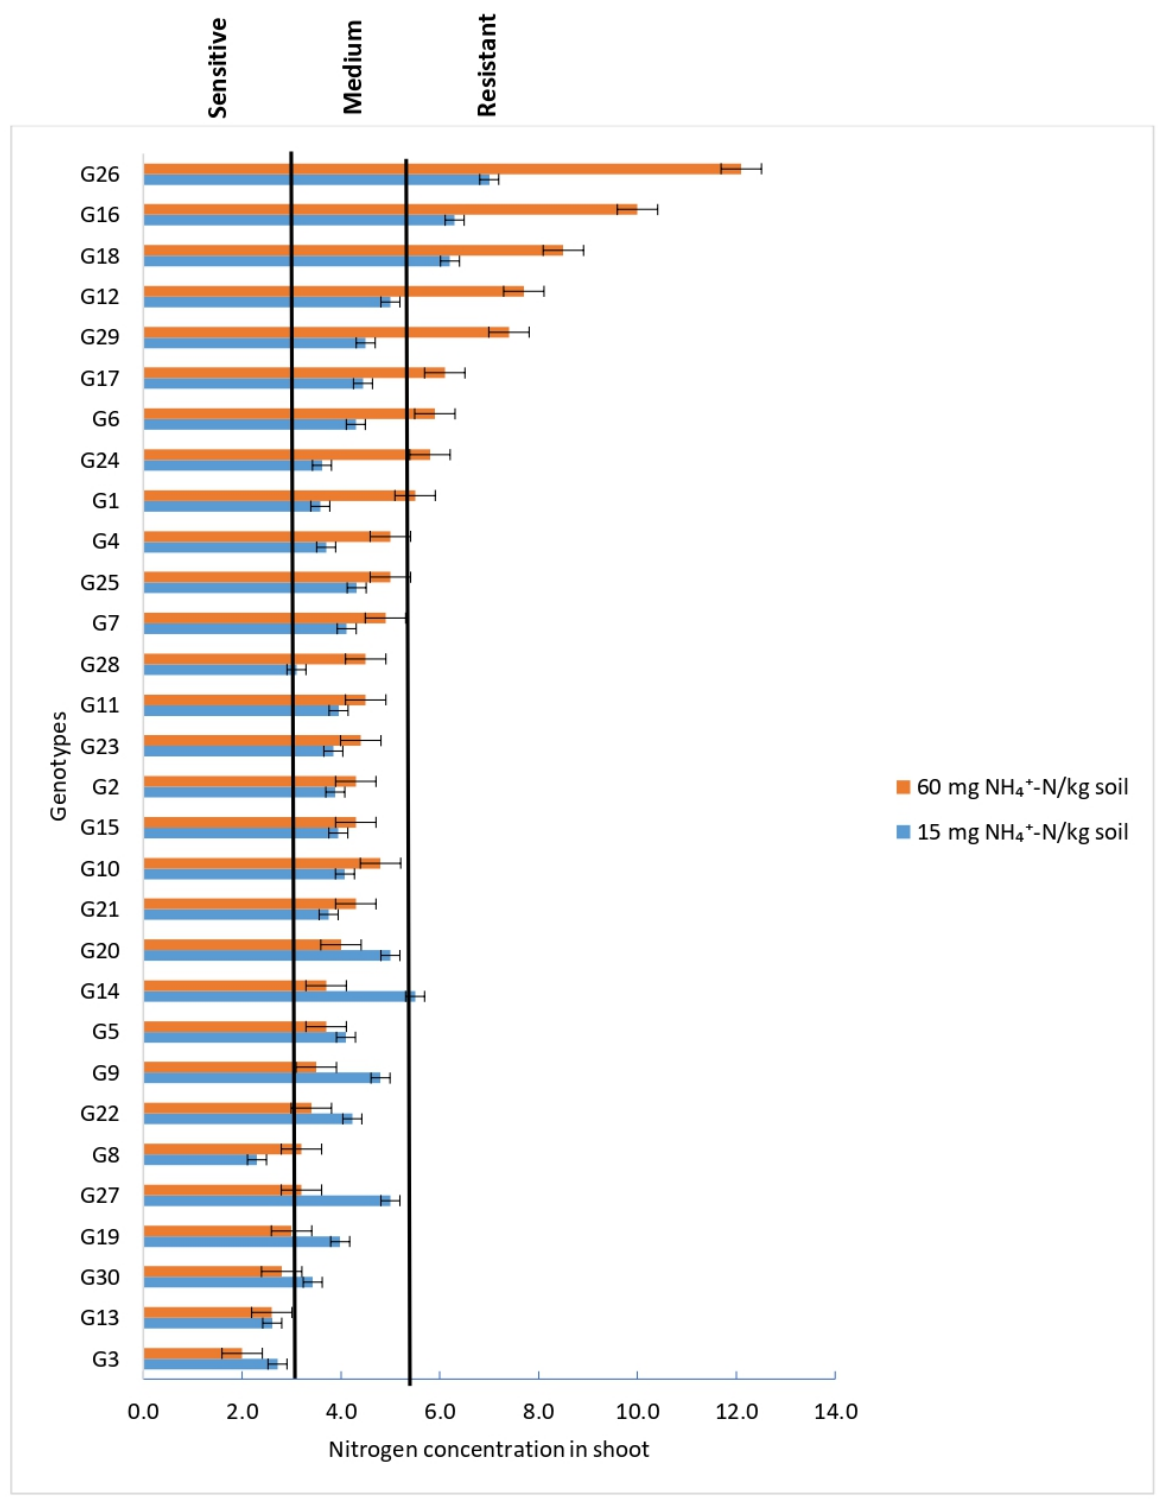
Figure 5. Nitrogen concentration in shoots of 30 canola genotypes (N concentration in shoot dry weight at 15 or 60 mg NH 4 + -N/kg soil). The resistance intervals were defined by subtracting or adding the value of two standard errors (for the genotype main effect) from the median point for all the genotypes. Means ± SE (n = 3).